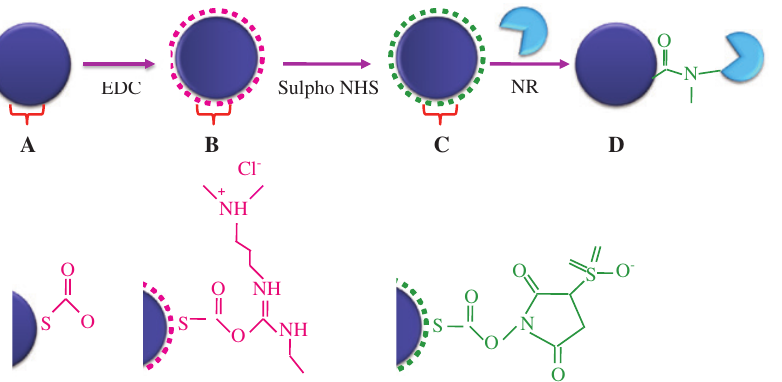
Scheme 3: Modification of metal and metal oxide nanoparticles for attaching nitrate reductase (NR). Citrate stabilized (A), N-ethyl- N ′ -(3-dimethylaminopropyl) carbodiimide hydrochloride (EDC) modified (B), N-hyhroxysuccinimide (NHS) terminated (C) and NR bound nanoparticles